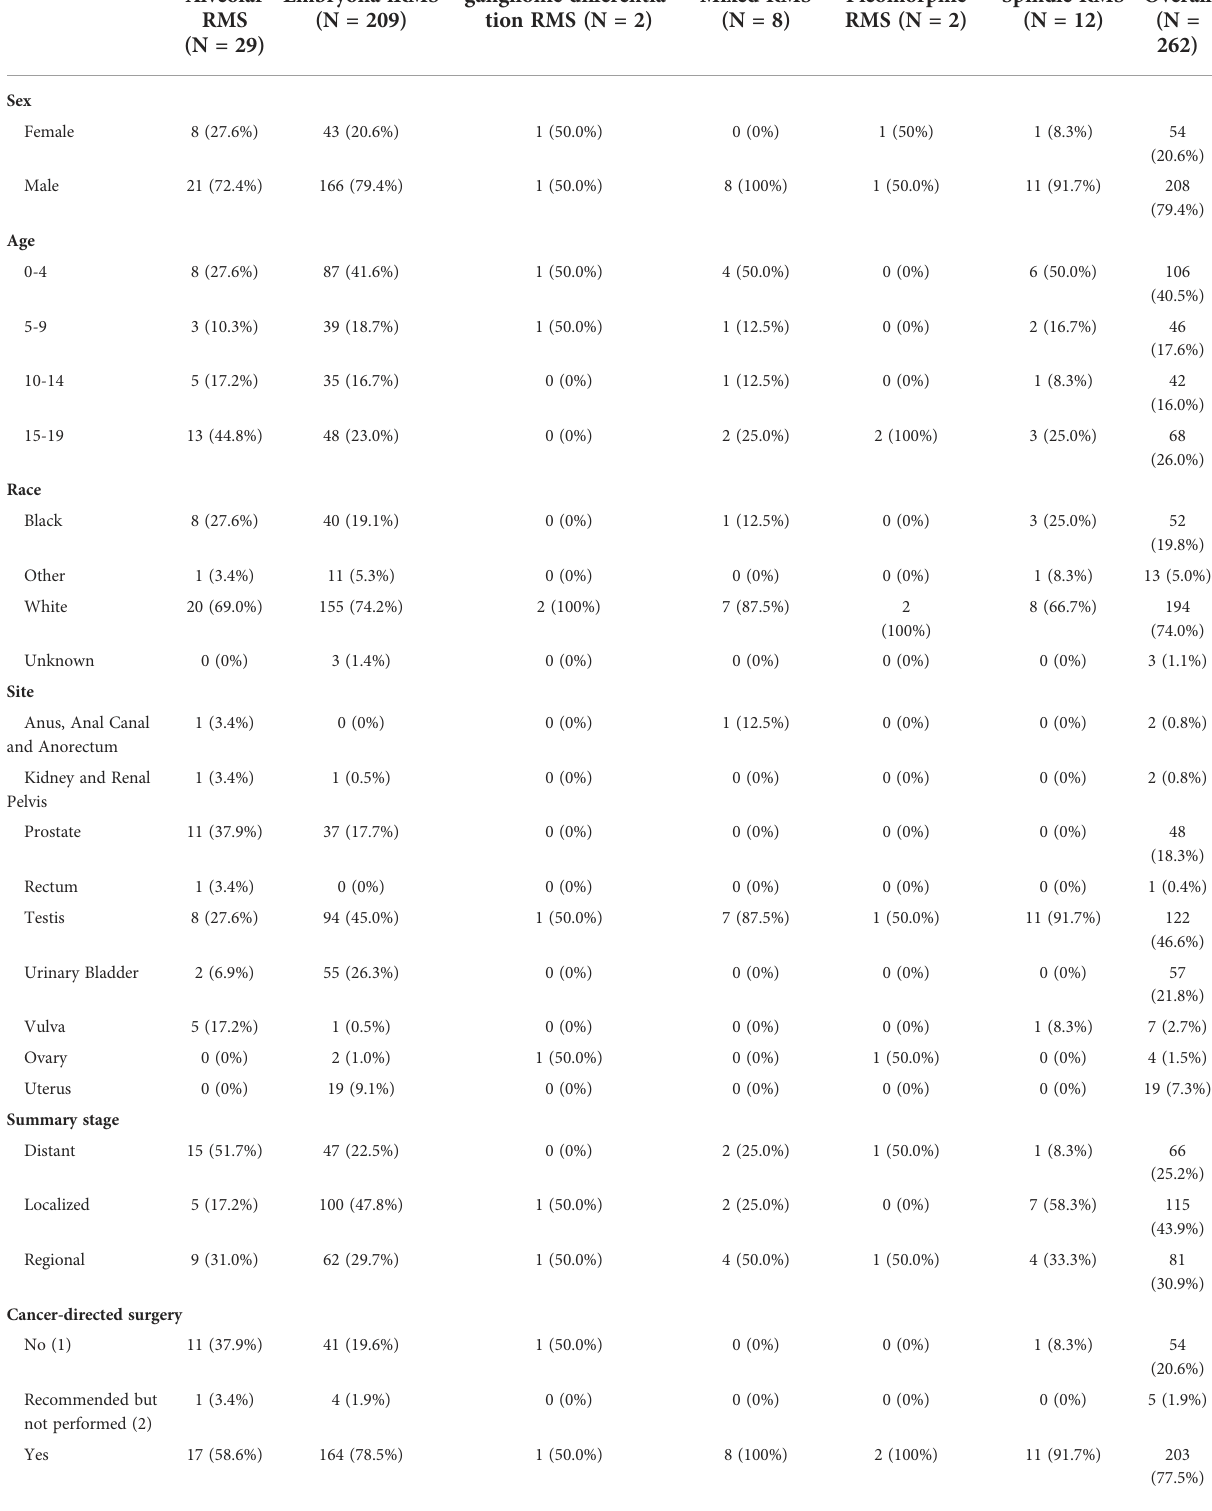
TABLE 1 Patient